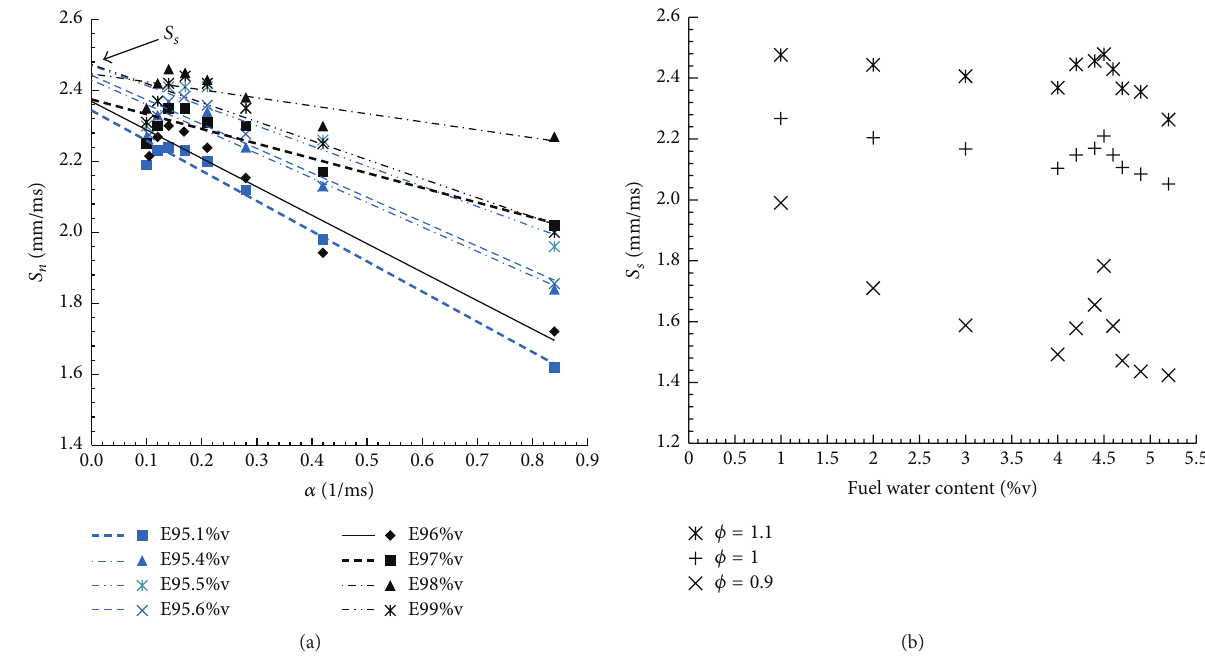
Figure 10: (a) Value of 𝑆 𝑛 ethanol to flame stretched rate 𝛼 . (b) Value of 𝑆 𝑠 ethanol to water content.